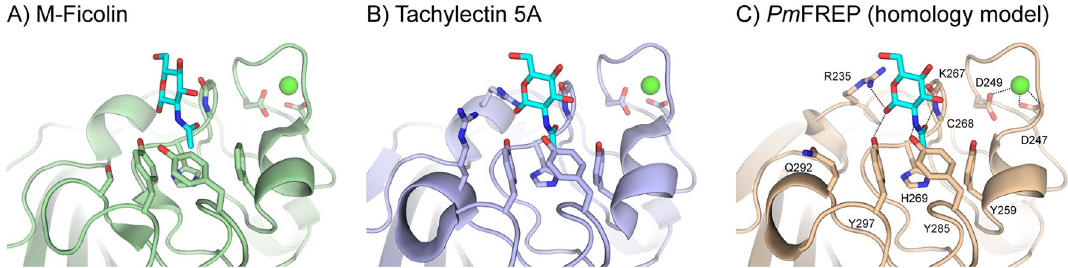
Figure 6. Comparison of the ligand binding site of ( A ) M-ficolin (crystal structure, PDB ID 2JHK), ( B ) Tachylectin 5A (crystal structure, PDB ID 1JC9), and ( C ) Pm FREP (homology model using SWISS-MODEL 44 , PDB ID 1JC9 as the template). The GlcNAc ligand is shown in cyan and the structural calcium ion is shown in (Rib), arabinose (Ara), xylose (Xyl), glucose (Glc), galactose (Gal), fucose (Fuc), rhamnose (Rha), mannose (Man), 3-deoxy-D-manno-2-octulosonic acid (KDO), glucoronic acid (GlcA), lactose (Lac), sucrose (Suc), fructose (Fruc), maltose (Mal), and cellobiose (Cell). These results suggested that His 6 Pm FREP was specific for acetyl group-containing carbohydrates, and while the ligand binding site and the calcium ion-binding residues were conserved (Fig. 6), the calcium ion is not required for ligand binding. To investigate recognition of carbohydrates in cellular context, we examined agglutination of red blood cells by His 6 Pm FREP. Because of the dimer of pentamer arrangement, His 6 Pm FREP is expected to agglutinate cells displaying its ligand. His 6 Pm FREP agglutinates red blood cells of A-, B- and O-type starting at concentration around 0.031 µM (Fig. 7A). Agglutination was inhibited by GlcNAc, GalNAc, ManNAc, and Neu5Ac (Fig. 7B). However, glucose and EDTA could not inhibit agglutination. GlcNAc and GalNAc could inhibit agglutination